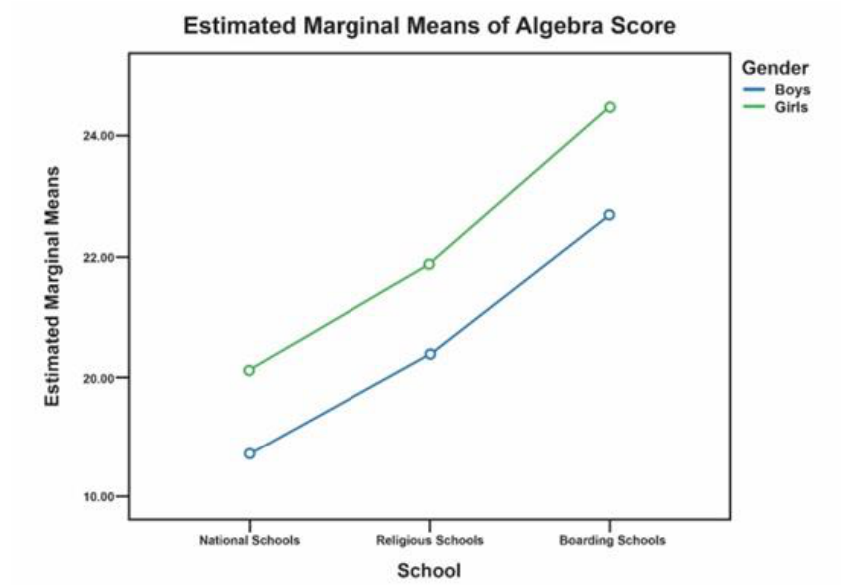
Figure 1. Profile plot for interaction effect between gender and types of